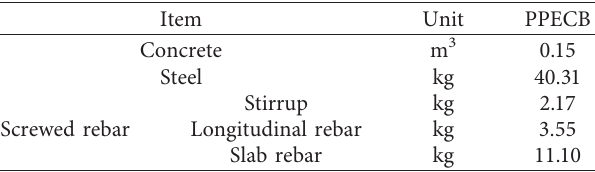
Table 4: Quantity survey of PPECBs.